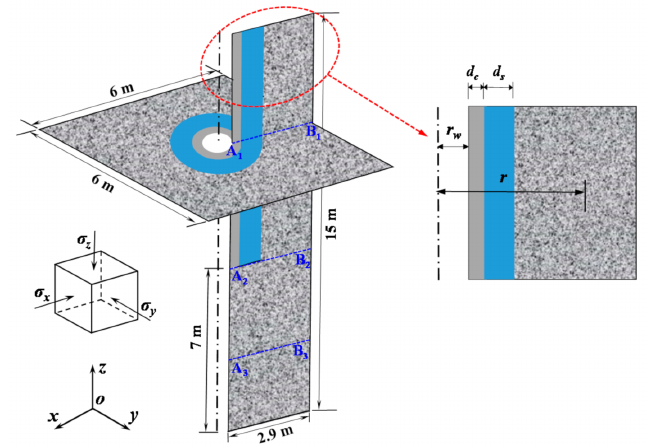
Figure 2. Geothermal wellbore stability calculation